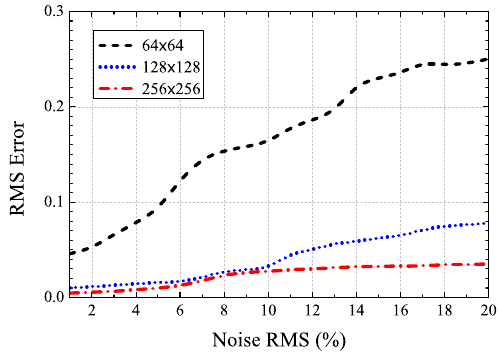
Figure 7. RMS error on estimation of the PSF initial value for different noise levels (in